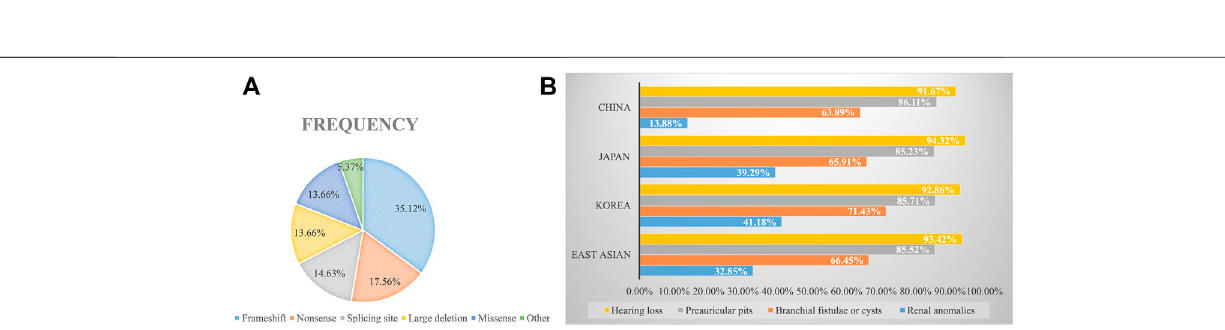
FIGURE 4 | (A) Frequencies of variant types in the EYA1 gene. (B) Estimated prevalence of clinical phenotypes among BOR/BOS patients with EYA1